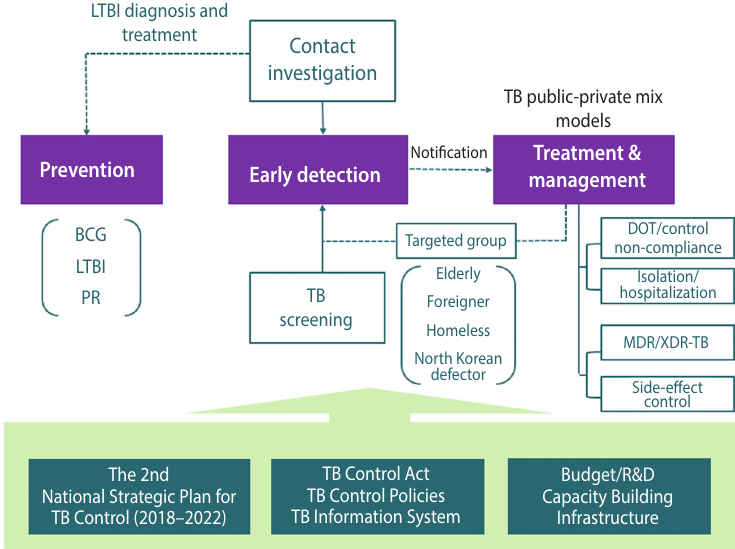
Figure 2. TB control framework of the Republic of Korea. TB, tuberculosis; LTBI, latent TB infection; BCG, bacille de Calmette-Guerin